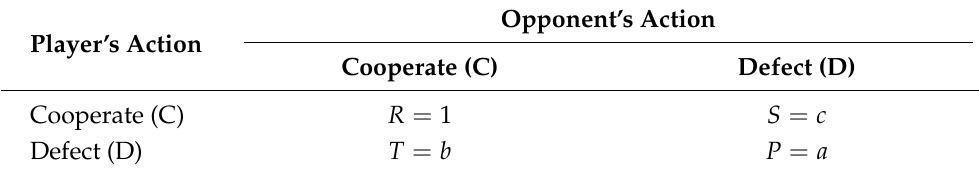
Table 1. Payoff function of a player in the SPD